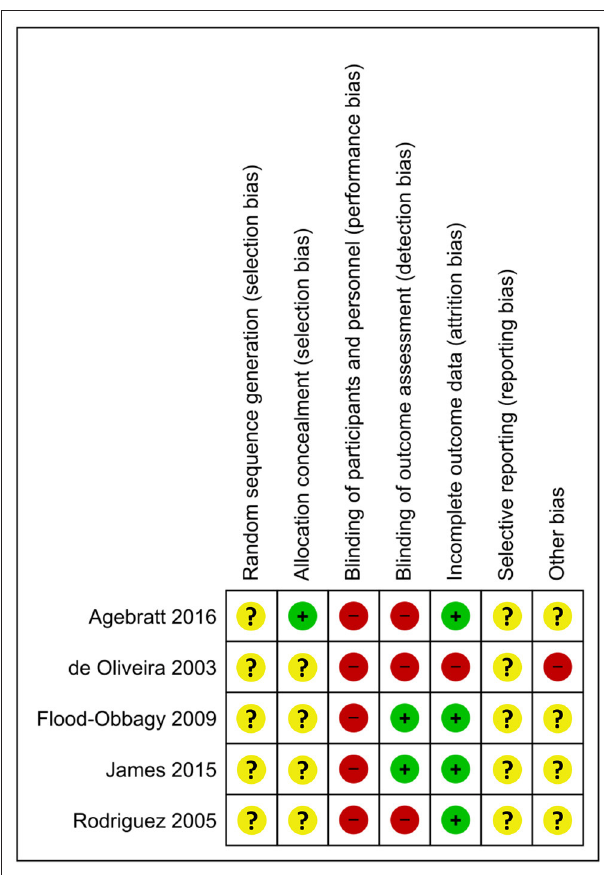
FIGURE 5 | Risk of bias summary for individual trials contributing to a secondary outcome: the impact of whole, fresh fruit consumption on energy intake in RCTs. Colored dots represent low risk (green), unclear risk (yellow), and high risk (red) in each risk of bias domain for each